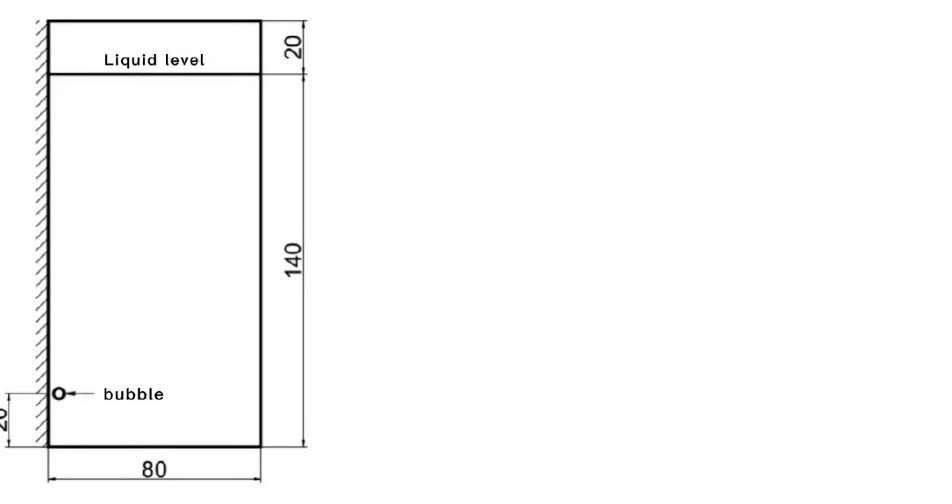
Figure 1. Two-dimensional calculation domain of the near-wall bubble with an initial diameter Figure 1. Two ‐ dimensional calculation domain of the near ‐ wall bubble with an initial diameter of 4 mm. of 4 mm.